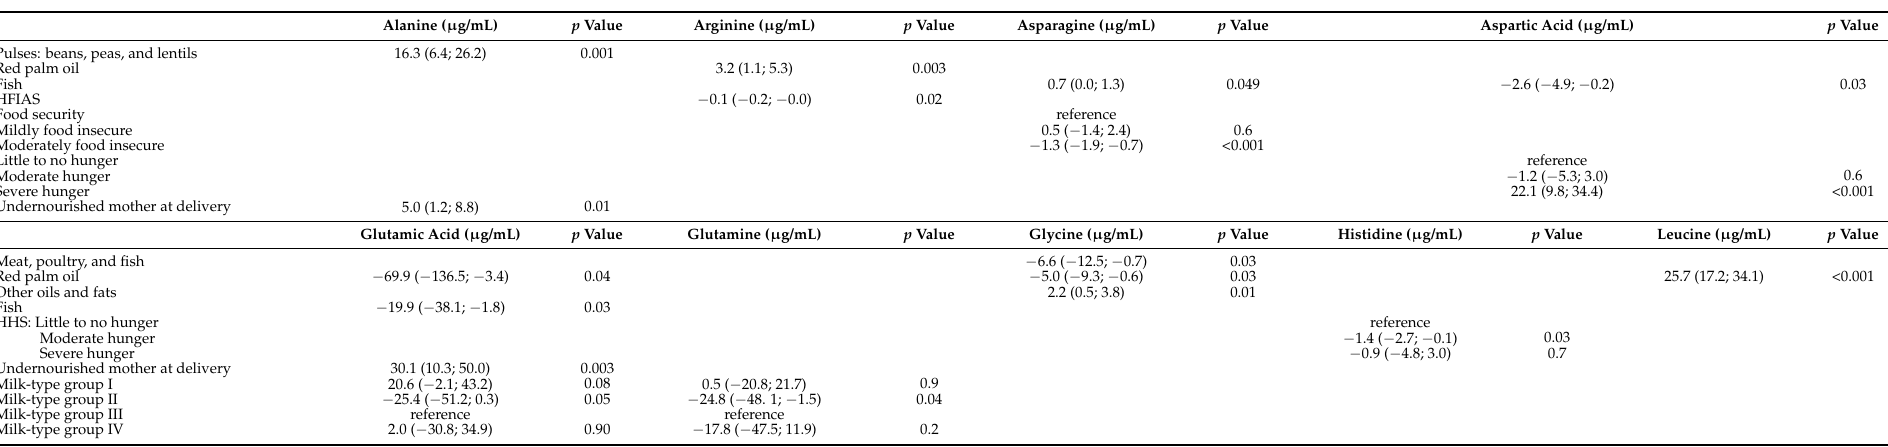
Table 9. Multilevel models of the dietary determinants of human milk free amino acids during the first 6 months of life (1).